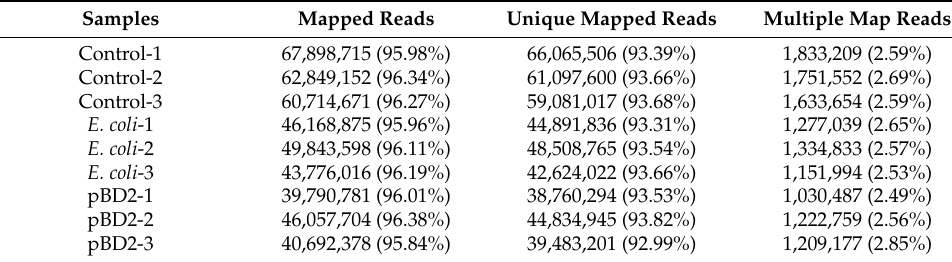
Table 2. Gene comparison efficiency